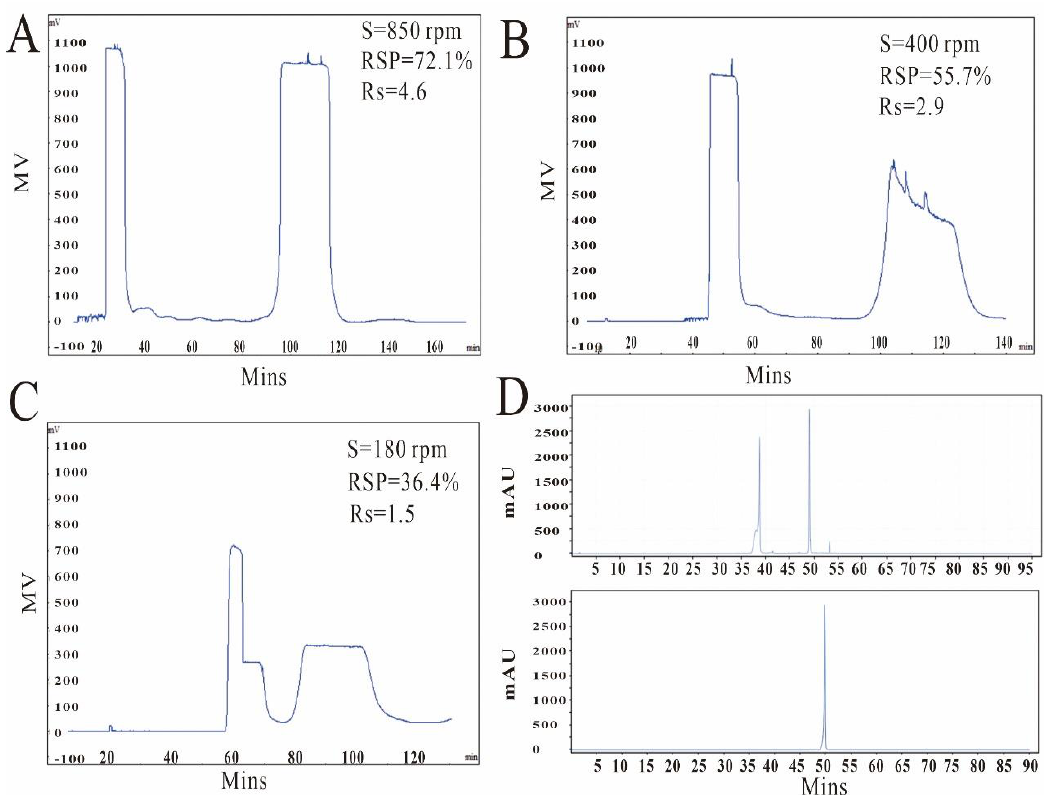
Figure 1. HSCCC and HPLC chromatograms of purification of myricanol from the pre-purified ethylacetate extract of the bark of M. rubra . The solvent system for HSCCC is n -hexane − ethylacetate − methanol − water (1:1:1:1, v/v/v/v ); flow rate: 3.0 mL min − 1 ; detection wavelength: 254 nm; separation temperature: 30 °C; sample size: 280 mg dissolved in 4 mL upper and 4 mL lower phase. Three rotation speeds (S), 850 rpm ( A ), 400 rpm ( B ) and 180 rpm ( C ), were selected to demonstrate that the resolution (Rs) is tightly correlated with the retention of the stationary phase (RSP). ( D ) HPLC chromatogram of the pre-purified ethylacetate extract of the bark of M. rubra (upper) and purified myricanol (lower).